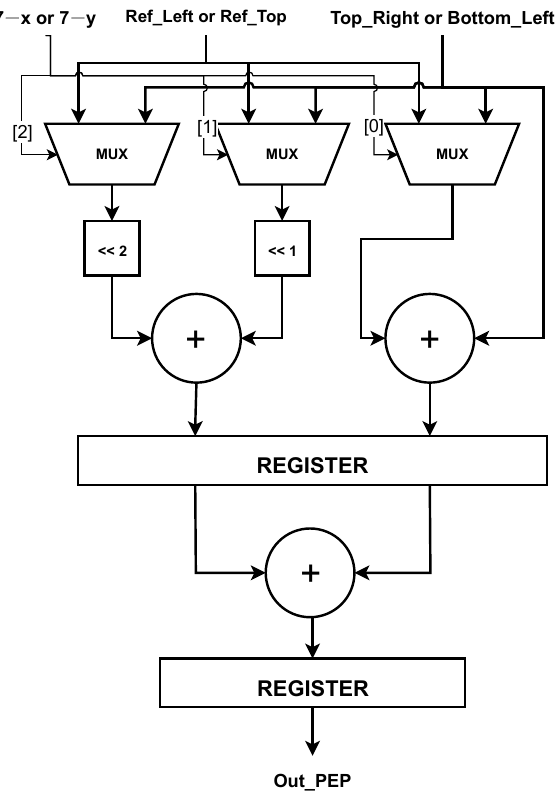
Figure 13. The structure of Processing Element for Planar (PEP)